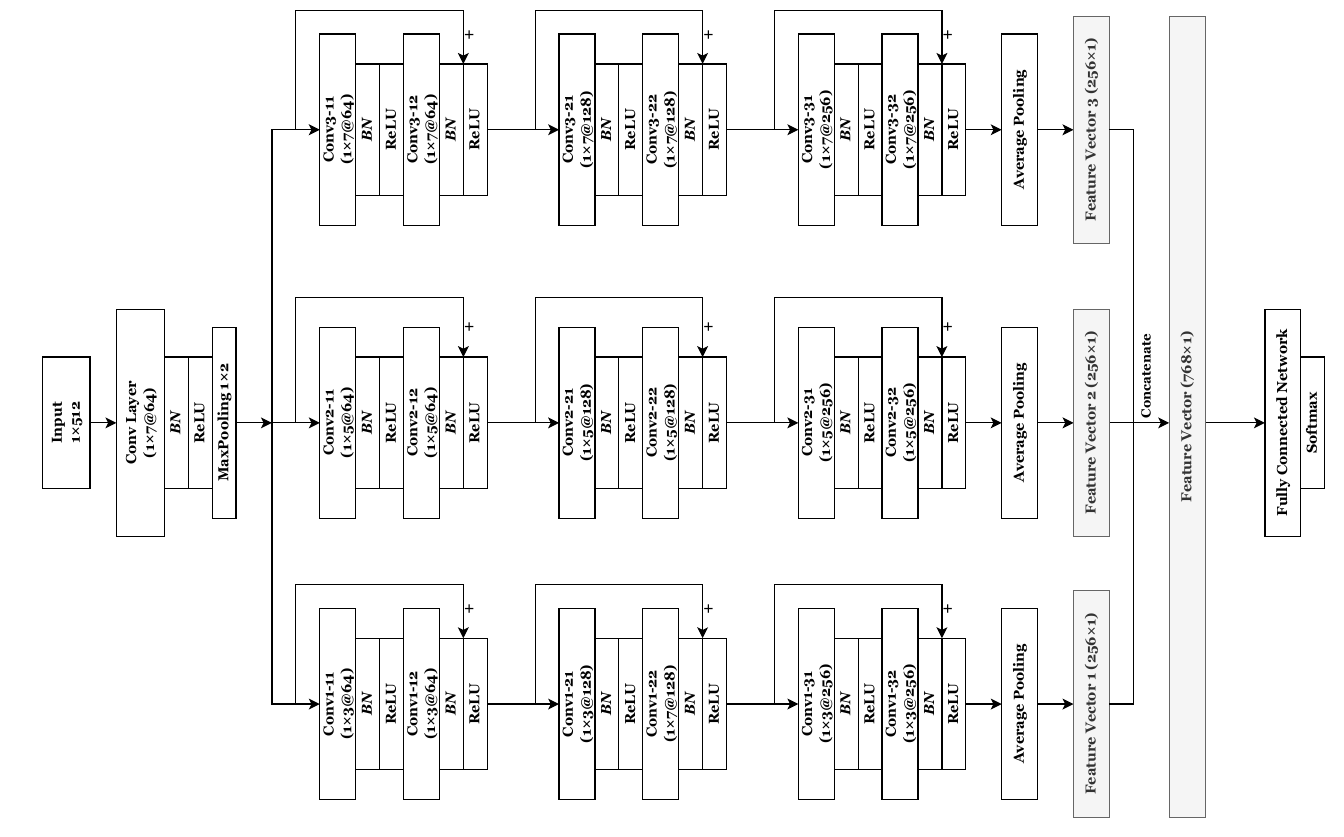
Figure 13. Structure of the multi-scale 1D